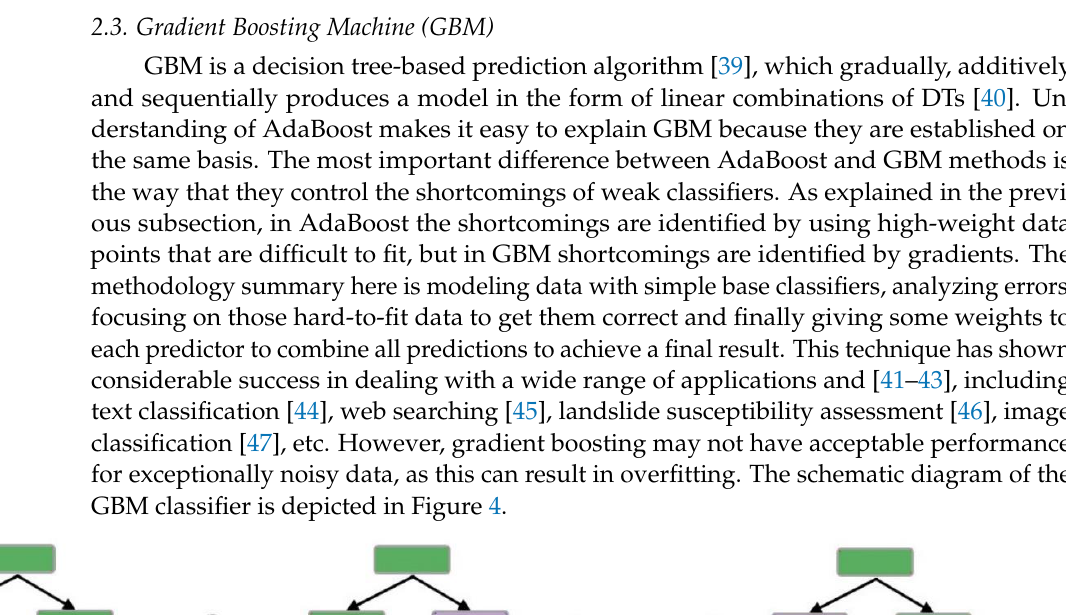
Table 3. Advantages and disadvantages of AdaBoost.